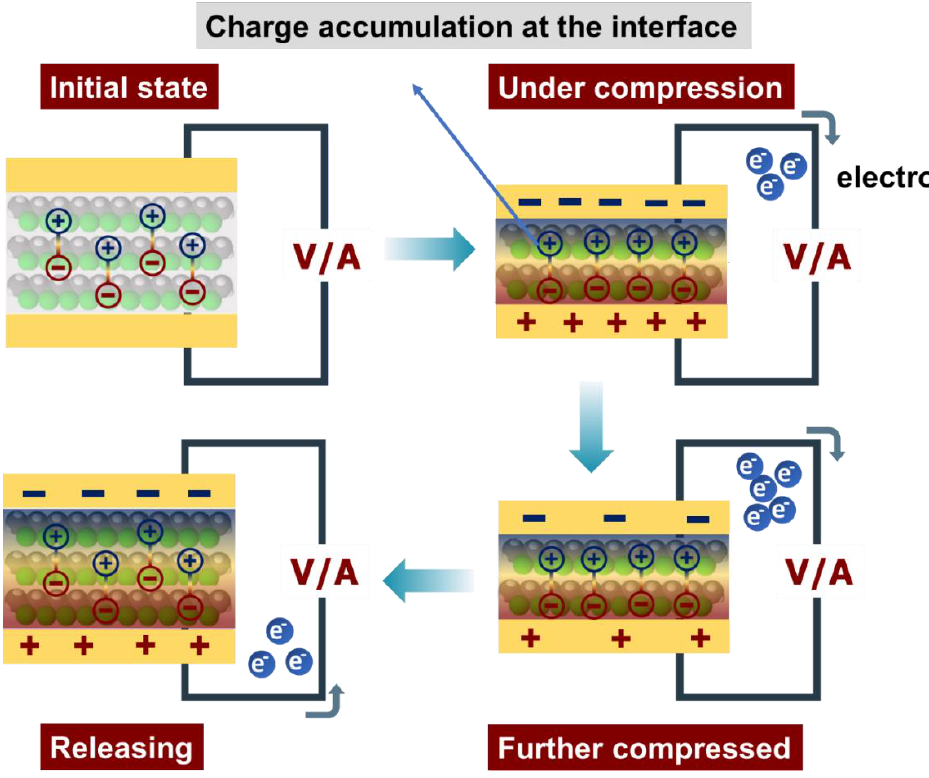
Figure 8. Working mechanisms of the piezoelectric composite film with a schematic illustration of the piezoelectric charge generation process.